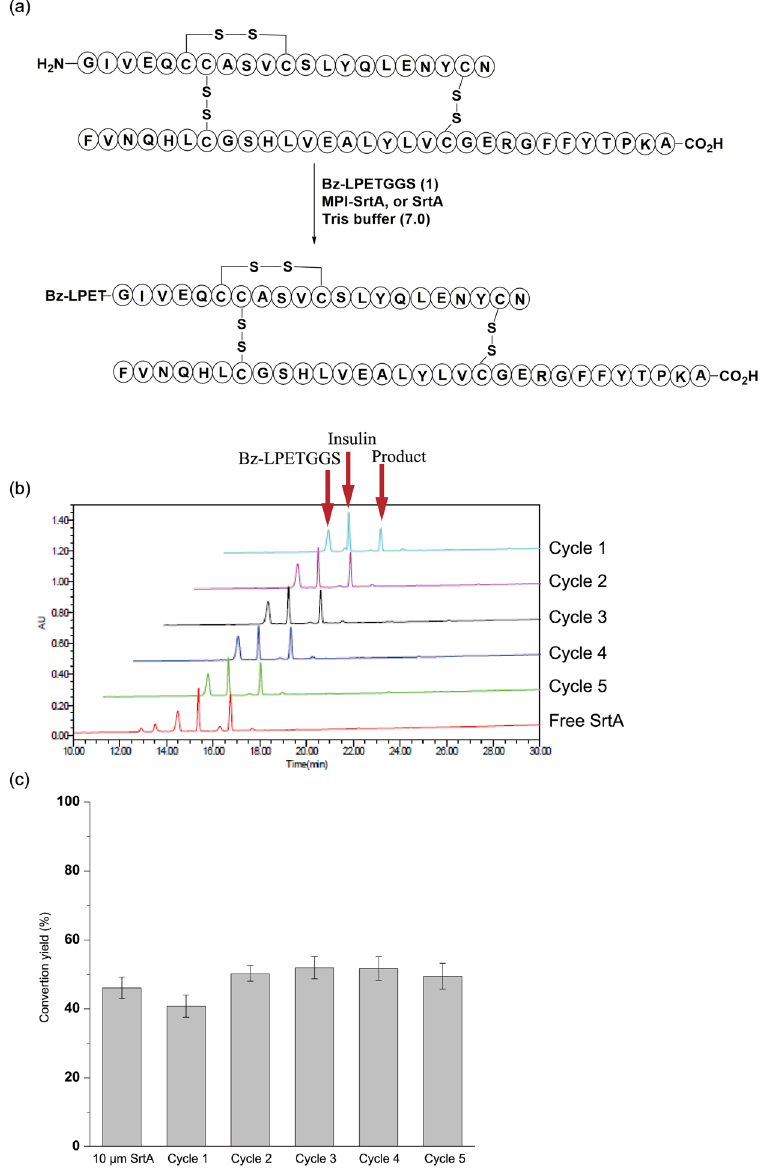
Figure 4. MPI-SrtA- or free SrtA-catalyzed site-specific insulin modification. ( a ) Ligation reaction of peptide Bz-LPETGGS 1 and insulin; conditions: 0.3 M Tris-HCl buffer (pH = 7.5) containing 0.15 M NaCl, 5 mM CaCl 2 , 2 mM 2-mercaptoethanol, 0.125 mM peptide 1 and 2.5 mM insulin in the presence of 100 μ L MPI-SrtA or 10 μ M free SrtA. ( b ) HPLC diagraph of MPI-SrtA- or free SrtA-catalyzed site-specific insulin modification; ( c ) Reuse and recycling of MPI-SrtA for site-specific insulin